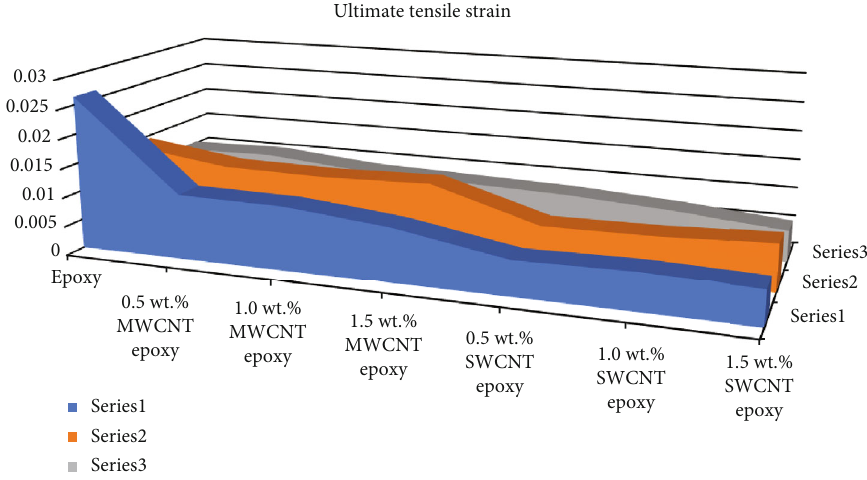
Figure 7: Average ultimate tensile strain results for CNT-epoxy composite specimens obtained from the tension test.